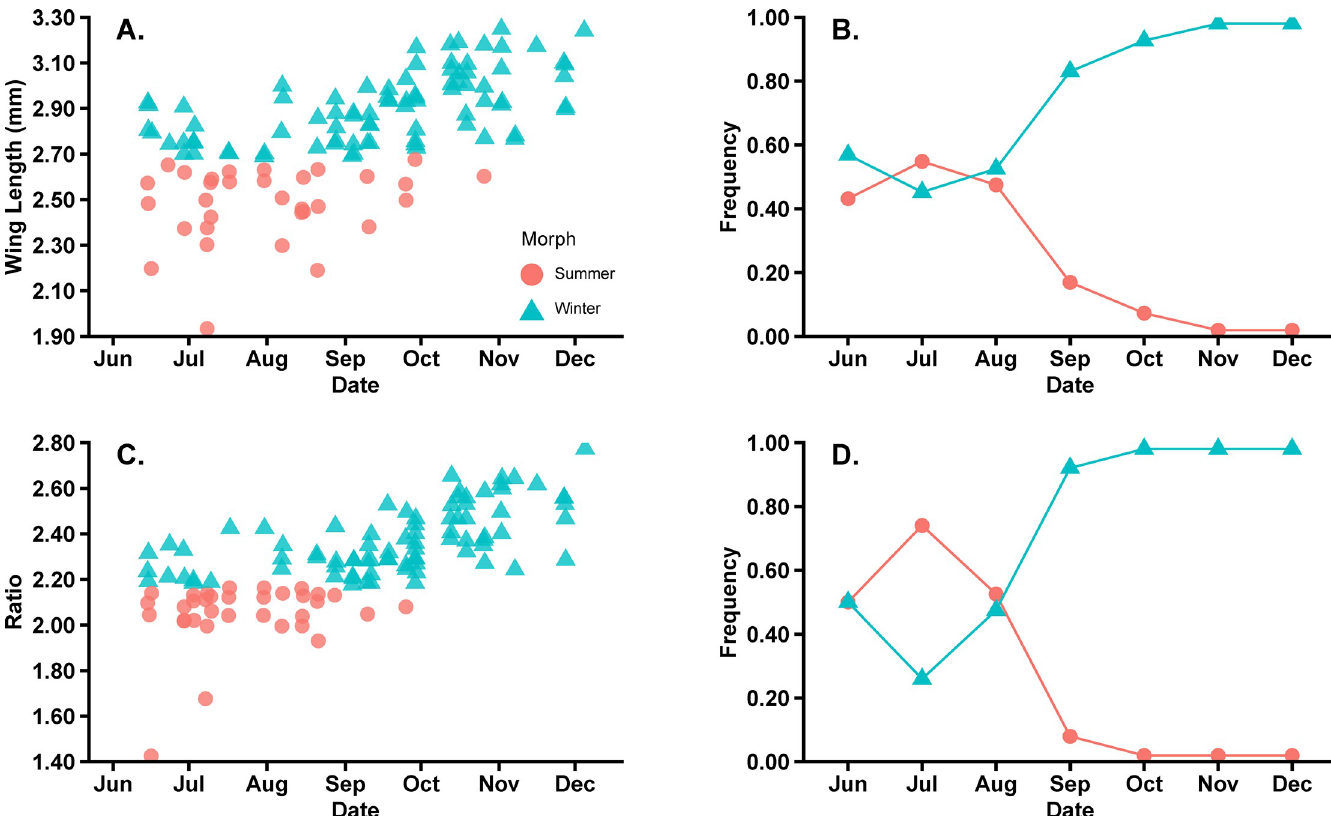
Fig 5. Predicted phenology of field caught female D . suzukii . Total of female D . suzukii morphs trapped from 2017–2018 (A and C) and the frequency (B and D) based on wing length (A and B) and transformed ratio of wing length to hind tibia length (C and D).